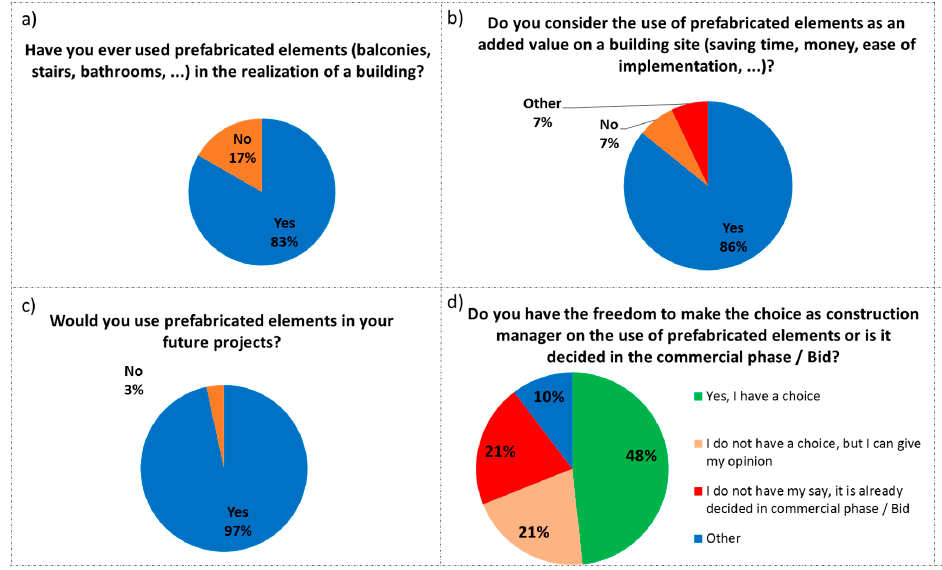
Figure 8. Questions for contractors related to prefabrication.